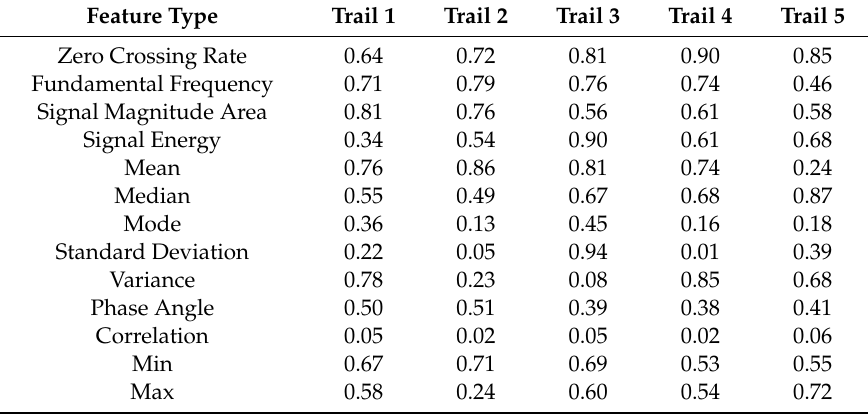
Table 10. Feature weights for di ff erent trials with the IM-SB dataset.